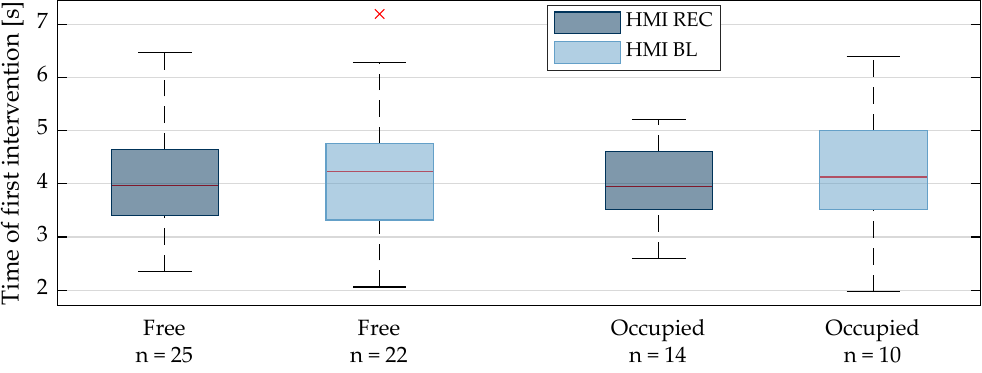
Figure 7. Time of first intervention. Outliers are marked as red